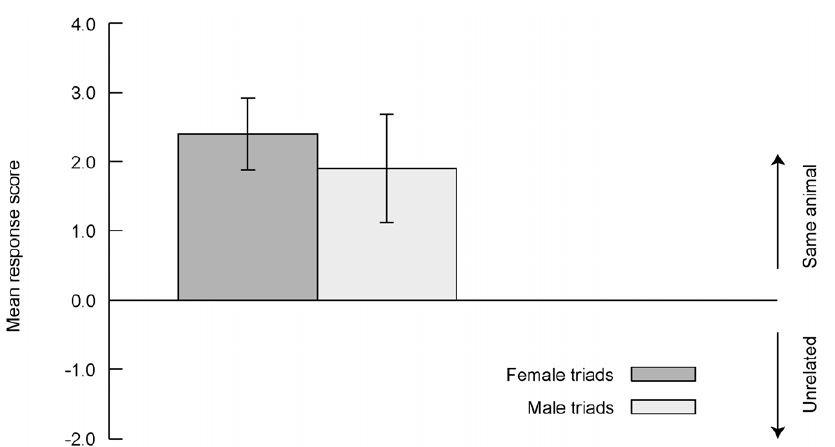
Figure 2. Performance on individual discrimination trials. Mean (and SD) resemblance scores between an alternative view of the same- versus a different (and unrelated) individual and the target image, in male-male and female-female triads. A mean of zero represents chance performance. Positive values indicate that a second image of the same individual was rated as being more similar to the target animal than was an equivalently- oriented image of an unrelated individual, with higher values indicating a greater disparity in perceived similarity.